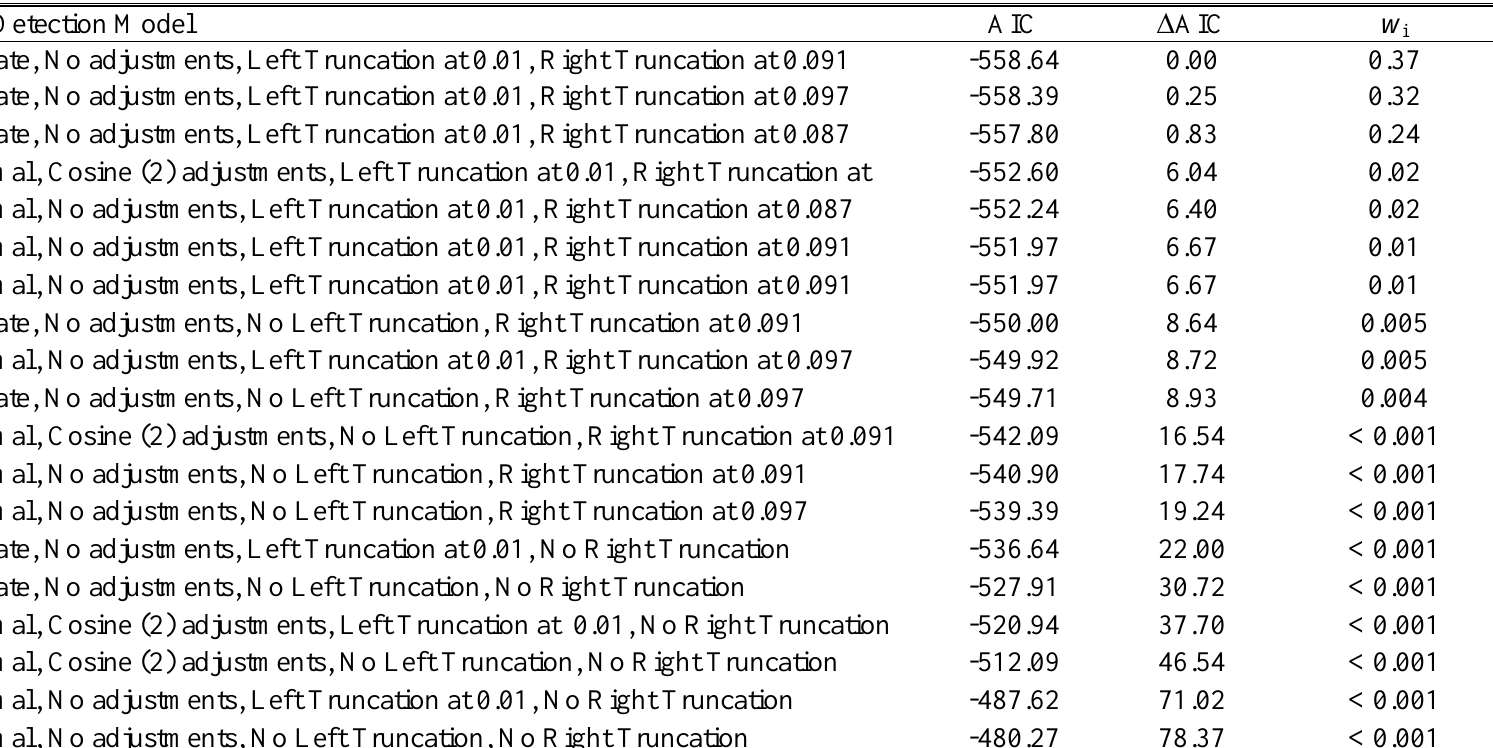
Table A1.1. Detection models used to evaluate cowbird density at five Black-capped Vireo breeding sites, comparing half-normal or hazard-rate key functions, cosine or simple polynomial adjustment functions, and variations in data truncation (truncation distances are in